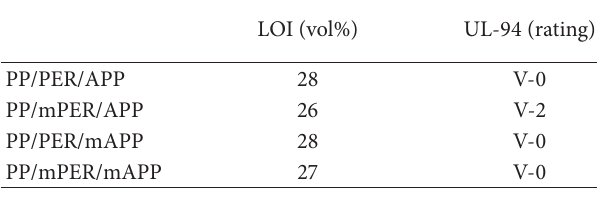
Table 1: LOI and UL94 results of the flame retarded PP compounds.